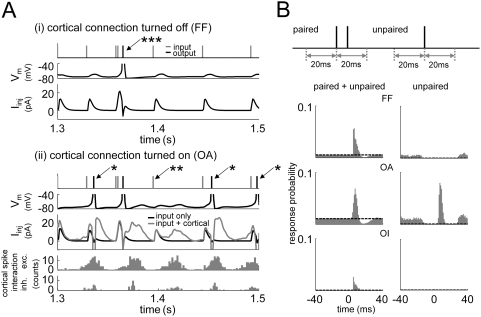
Responsiveness to weak FF inputs is enhanced by spontaneous cortical
gamma frequency oscillation.(A) (i) Cortical connections are turned off (FF). Neurons receive only FF
inputs. Each weak (<30 µS/cm2) FF input
raises some current and voltage fluctuation but cannot cause a cortical
output spike unless two or more inputs are closely paired
(***). (ii) Cortical connections are turned on
(OA). In the presence of cortical gamma oscillation, each neuron
receives cortical spikes from nearby neurons. Since cortical activity
has the gamma frequency oscillation pattern, each neuron is provided
with a periodic current fluctuation. This cortical current amplifies
weak FF inputs to drive output spikes (*). This response
enhancement depends on the phase of oscillation, so a FF input at an
oscillation node is not amplified (**). (B) The response
probability of entire (paired+unpaired) and single (unpaired)
FF inputs (weak input strength ∼25 µS/cm2)
for different cortical activity states. In both cases (paired and
unpaired), input spikes were chosen only if there were no other spikes
within 20 ms before each input. Paired inputs have another input within
20 ms after each input. Cortical output spikes were counted as is their
relative timing to each input spike were 0 ms). All three cases show a
non-zero response peak for the entire input. For unpaired input, only
the OA network can respond. In each correlogram, response probability
was normalized by the number of proper (entire or unpaired) FF input
spikes. For the responsiveness calculation (Figure 3A), each peak area was
measured above background activity level (dashed line). Background
activities were measured within a window from −10 ms to 0
ms.